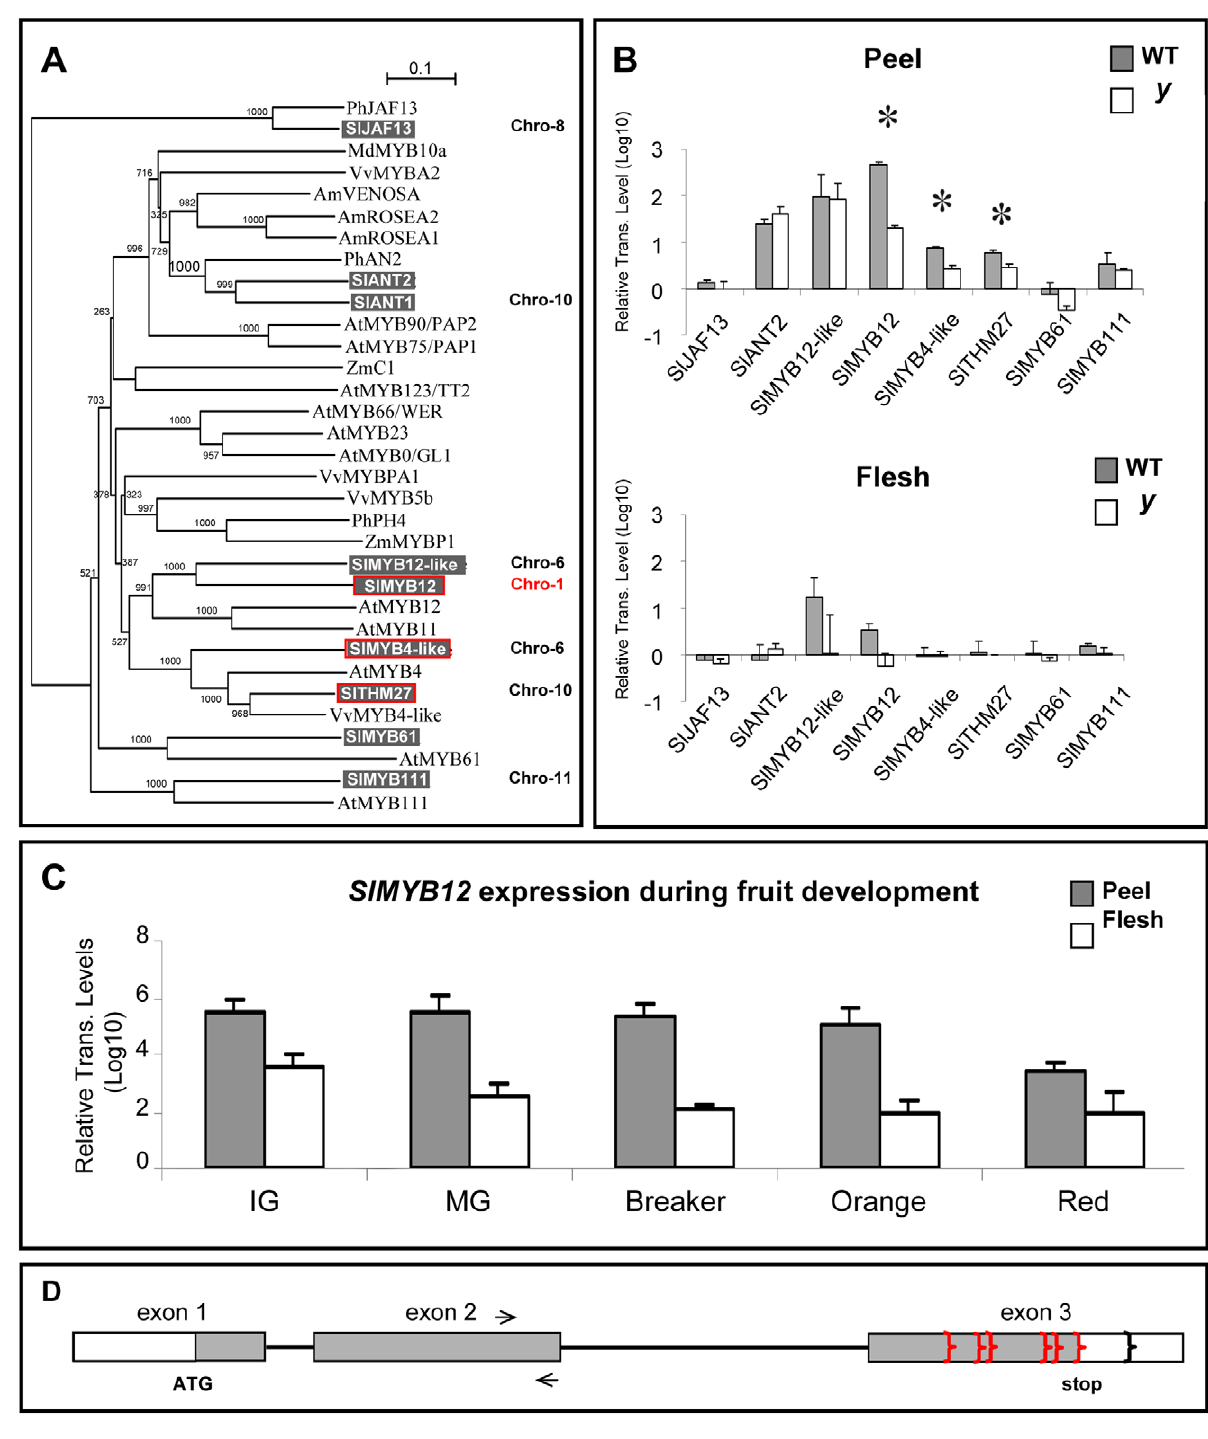
Figure 8. Phylogeny and expression analyses of putative phenylpropanoid/flavonoid-related transcription factor genes. (A) Phylogenetic analysis of the putative tomato regulators reported in our study and known phenylpropanoid/flavonoid-related transcription factors from other species. The ClustalX and NJplot softwares were used to compute the tree and its significance (bootstrap) values. (B) RT–PCR relative expression analyses of selected tomato transcription factors putatively related to the regulation of the phenylpropanoid/flavonoid pathway in wt and y mutant tissues at the breaker stage of fruit development. Indicated by asterisks are significant differences analyzed by Student’s t-test (n=3; P , 0.05; bars indicate standard errors). Gene identifiers and primers are listed in Table S3. (C) Real Time RT–PCR relative expression analysis of SlMYB12 in wt fruit tissues through five developmental stages reveals a peel-associated expression pattern. IG, Immature Green; MG, Mature Green; Br, Breaker; Or, Orange; Re, Red, stages of fruit development (n=3; P , 0.05; bars indicate standard errors). (D) Structure of the SlMYB12 gene. Gray regions represent coding sequence and white represents UTRs. Arrows indicate the position of RT–PCR primers, red brackets indicate the positions of premature polyadenylation sites (in the y-1 mutant allele), and the black bracket indicates the position of the alternative wt polyadenylation site.